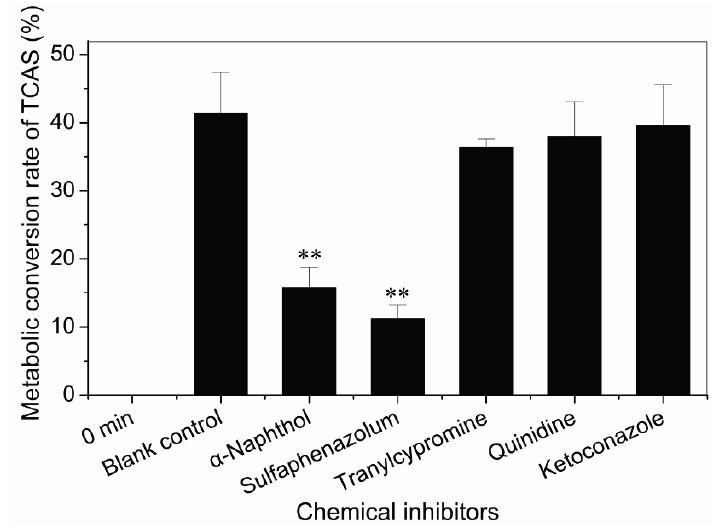
Figure 2. Metabolic conversion rate of TCAS in human liver microsomes plus inhibitors. Values are presented as M ± SD (n = 3). (* p < 0.05, ** p < 0.01, compared with blank